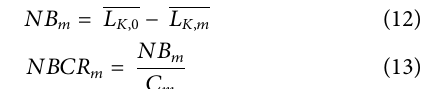
Frontiers in Built Environment |